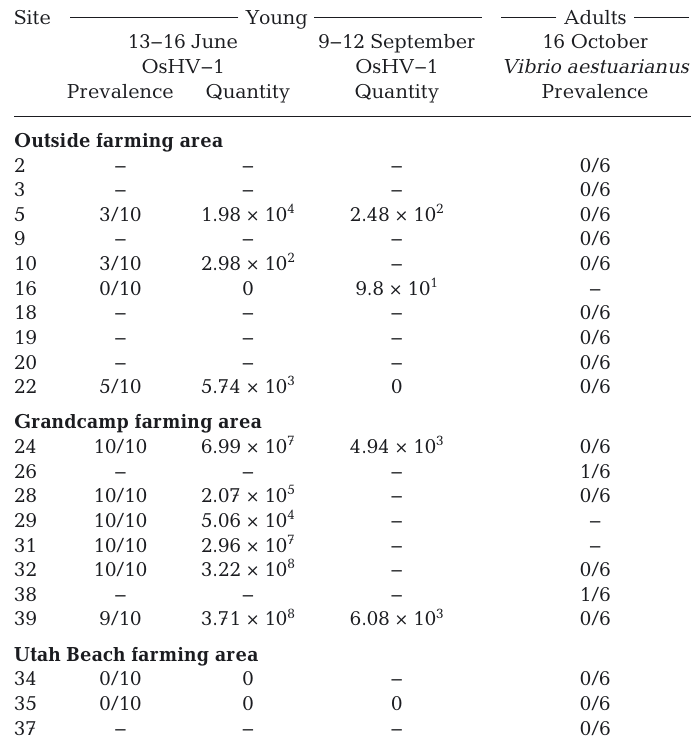
Table 2. Pathogen detection in young and adult sentinel Pacific oysters. Prevalence indicates the number of positive individuals out of the total